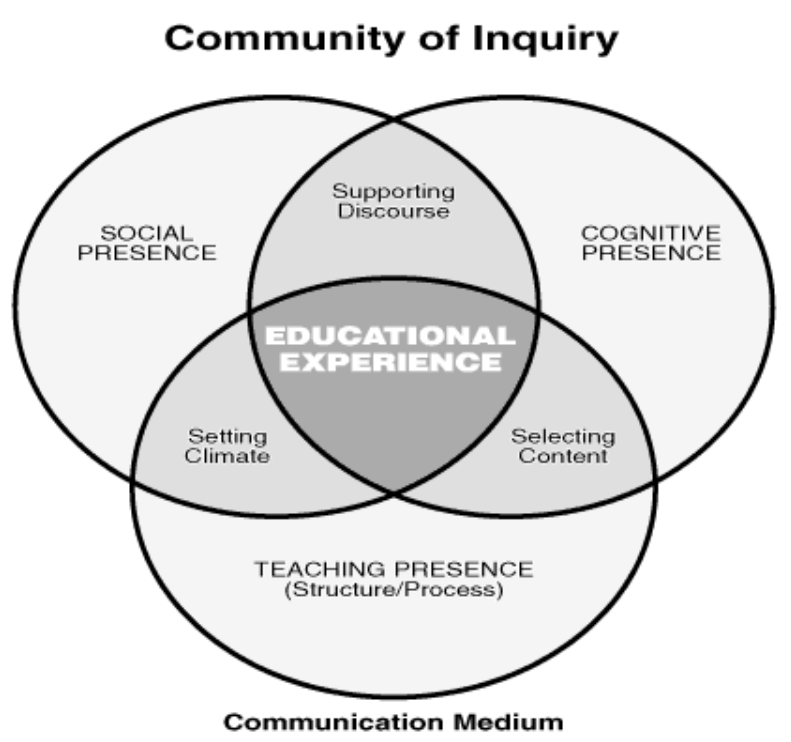
Figure 1 . Elements of an educational experience (Garrison, Anderson, & Archer,